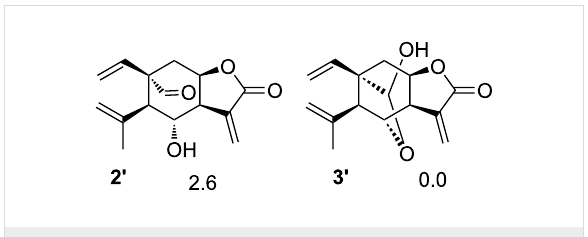
Figure 2: Schematic representations of the calculated C5 epimeric structures of 2 and 3 . Relative electronic energies in kcal/mol. The energies are relative to 1a